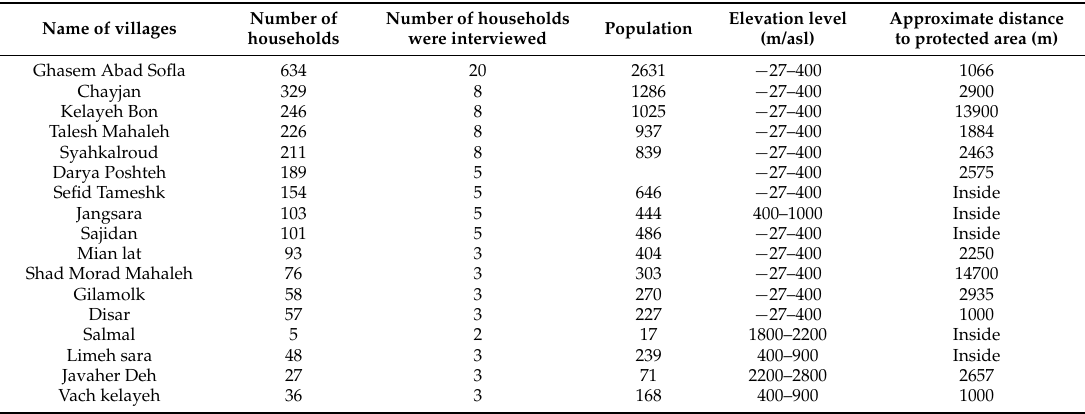
Table 2. Villages selected for direct interviews based on a range of criteria including population size, number of households, and geographical